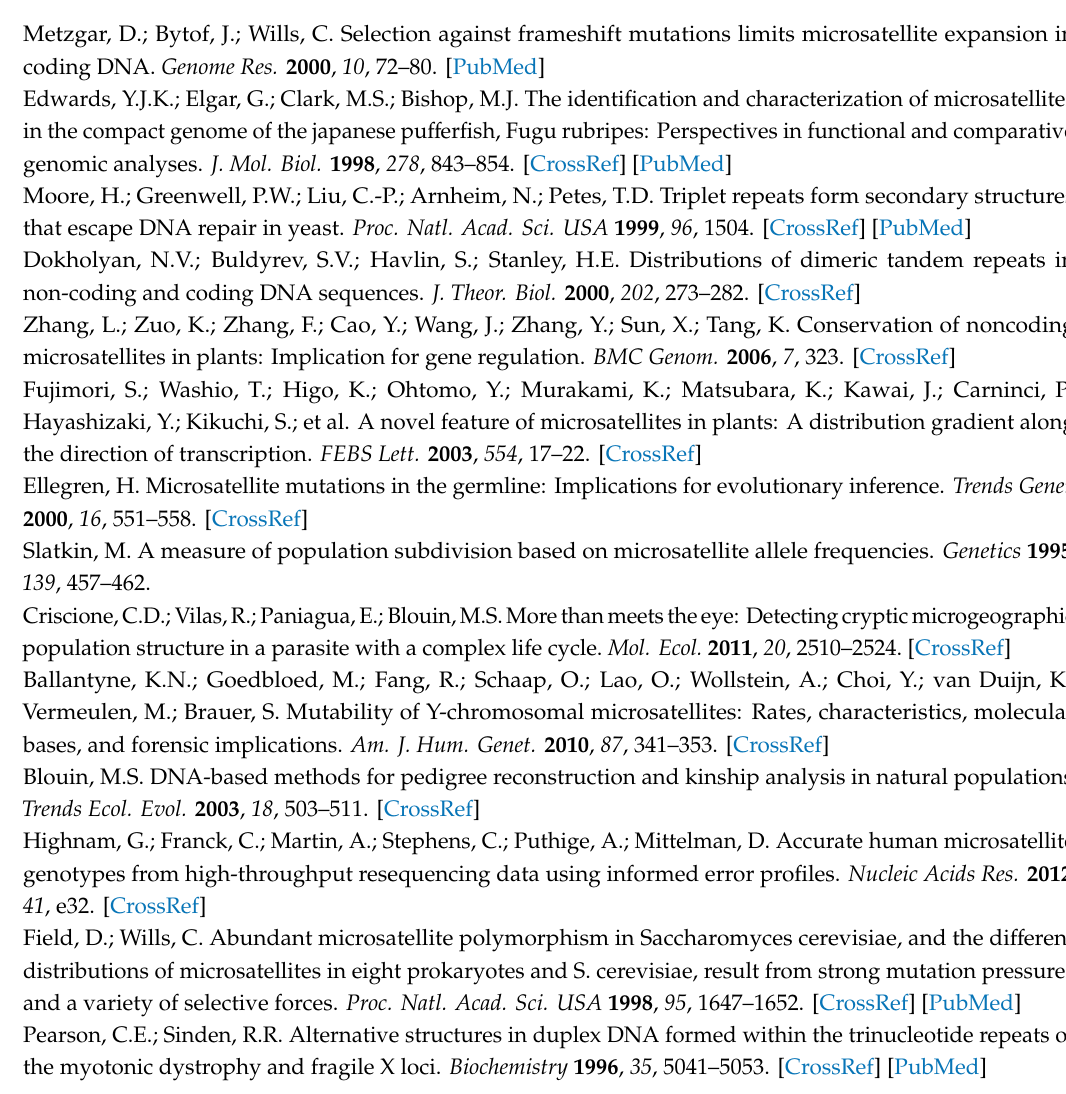
Figure S1. Taxonomic instability indices; Figure S2. Microsatellite inference and the type of sequencing; Figure S3. Measures of the quality of genomes; Figure S4. BUSCO scores; Figure S5. Tip rates; Table S1. Genome accession numbers; Table S2. Gene accession numbers; Table S3. Node constraints; Table S4. ANOVA results of microsatellite content by order; Table S5. ANOVA results of microsatellite content by centromere